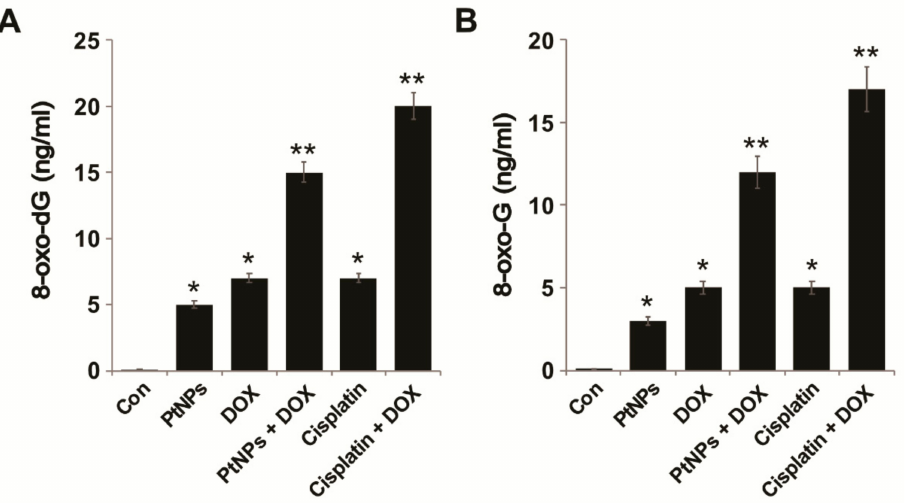
Figure 13. PtNPs and DOX increase oxidative damage to DNA and RNA. U2OS cells were treated with PtNPs (10 µ g / mL), DOX (1 µ g / mL), CIS (5 µ g / mL), or a combination of PtNPs (10 µ g / mL) and DOX (1 µ g / mL) or combination of DOX (1 µ g / mL) and CIS (5 µ g / mL) for 24 h and then ( A ) 8-oxo-dG and ( B ) 8-oxo-G levels were measured. Di ff erences between the treated and control groups were measured using Student’s t -test and statistically significant di ff erences are indicated by * ( p < 0.05). The results are presented as mean ± standard deviation of three experiments. * p < 0.05 was considered significant; ** p < 0.01 was considered highly significant and *** p < 0.001 was considered very highly